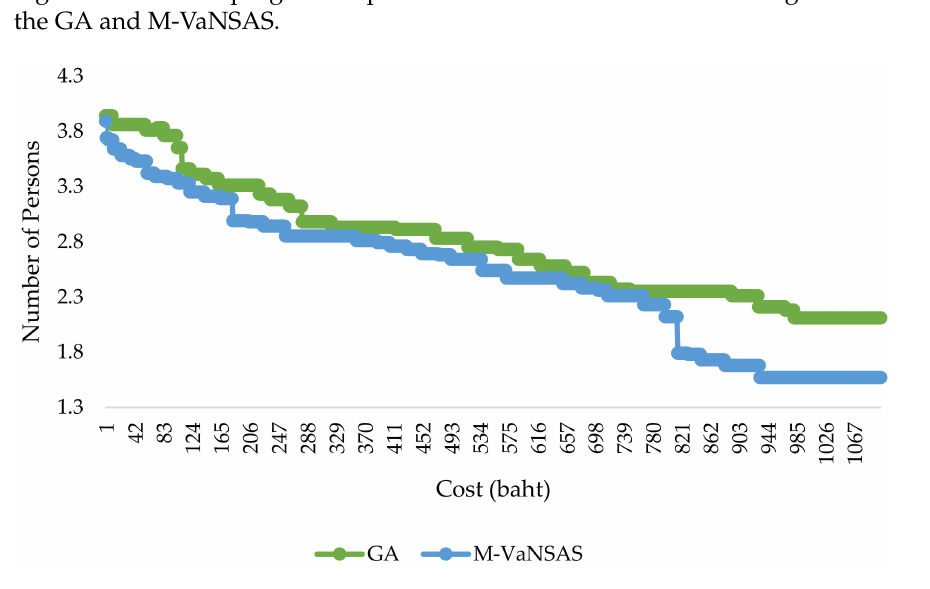
Figure 8. Progressive plot of the development of the best average cost per person found during the search with the proposed